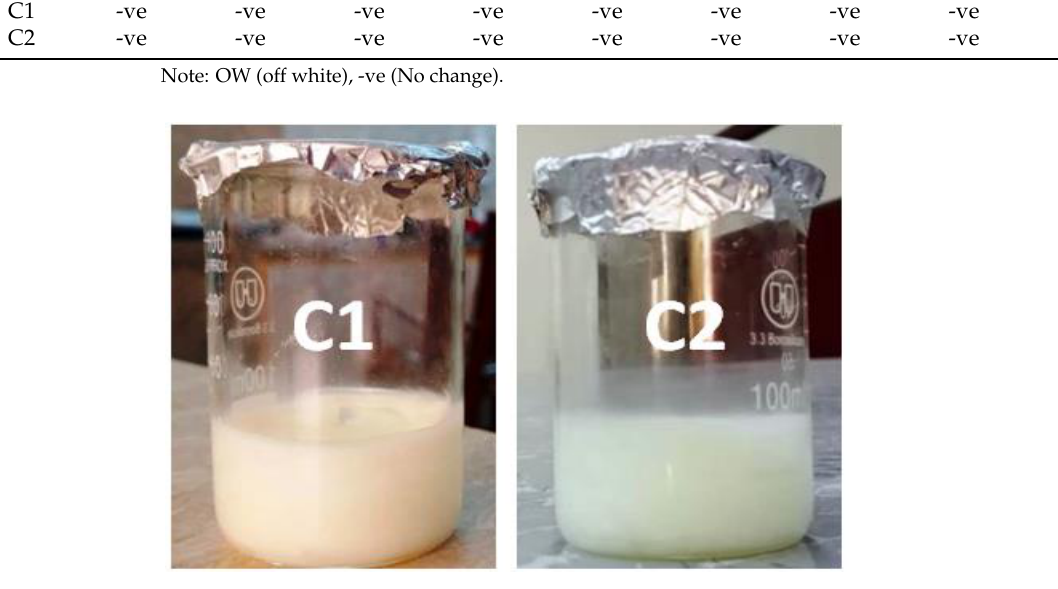
Figure 3 . Photographs of formulations C1 and C2. Figure 3. Photographs of formulations C1 and